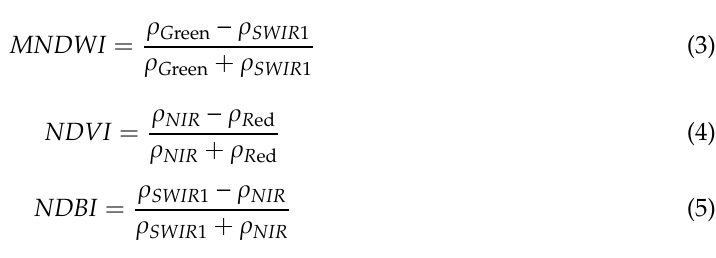
classification results using Kappa coe ffi cients. The Kappa coe ffi cients for 2013, 2015, and 2017